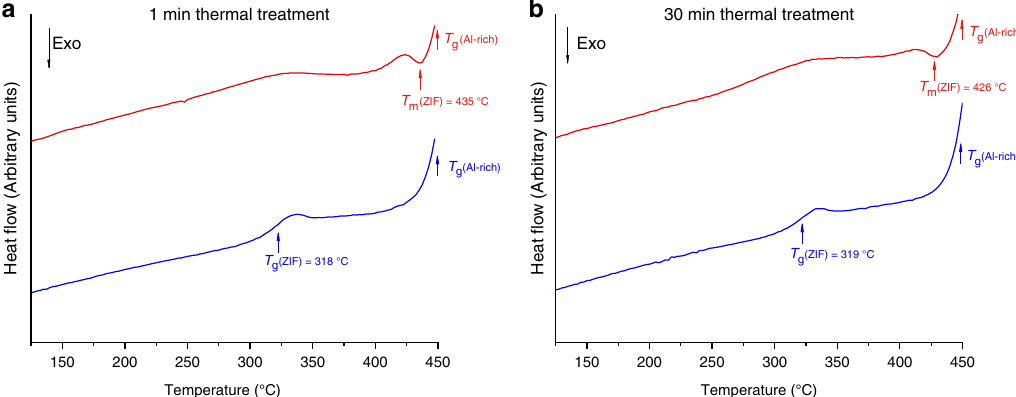
Fig. 2 Glass transition behaviour. Thermal response of (ZIF-62)(Al-rich)(50/50) on the fi rst (red) and second (blue) DSC heating scans. a (ZIF-62)(Al- rich)(50/50) – 1 min sample. b (ZIF-62)(Al-rich)(50/50) − 30 min sample. An offset has been added to improve